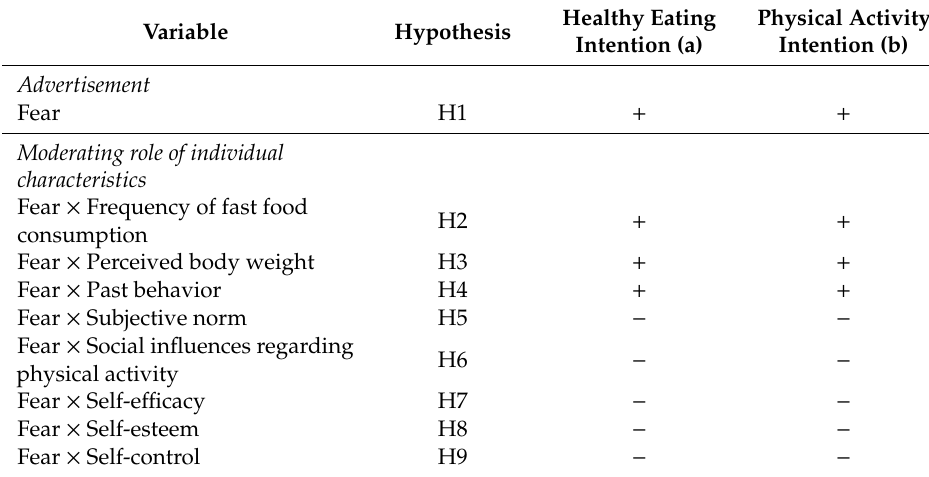
Table 1. Proposed